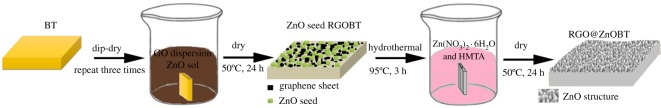
Schematic illustration of the synthetic process of RGO@ZnOBT.